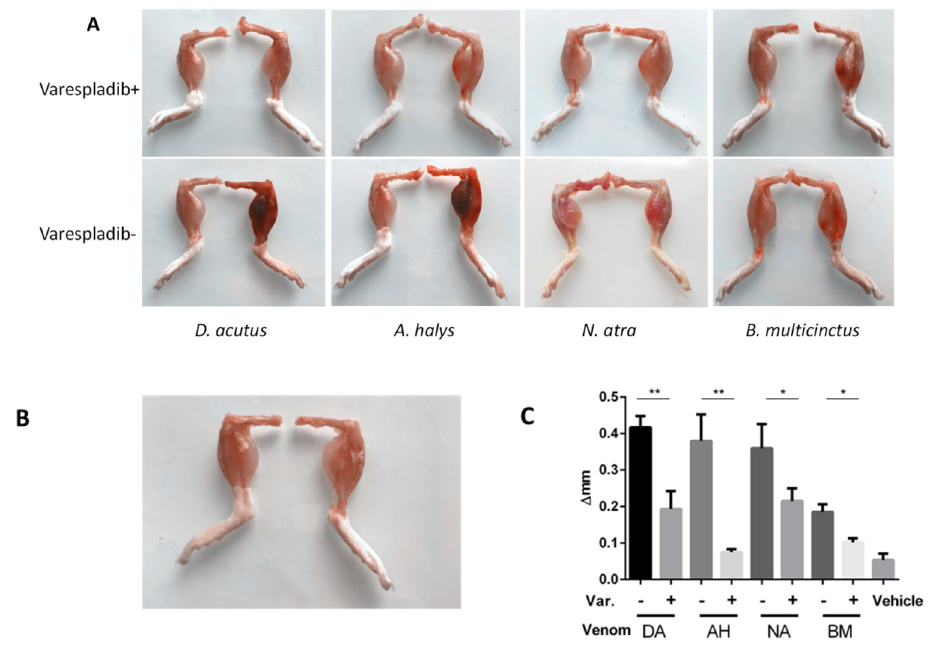
New Figure 3 (the legend is